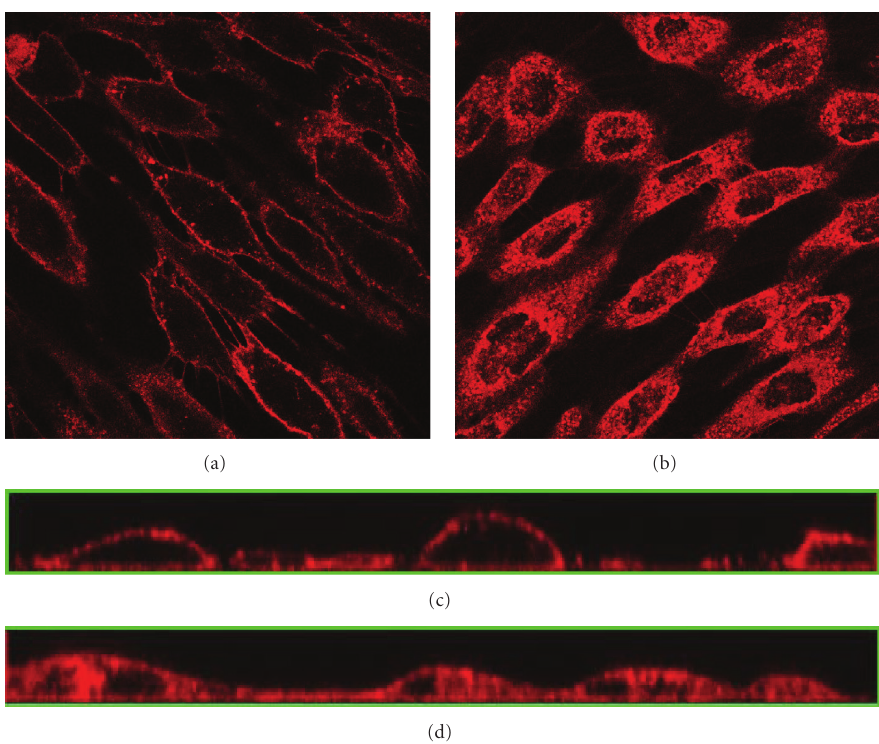
Figure 4: E ff ects of enzymatic removal of heparan sulfate before heparan sulfate staining of PAEC grown under di ff erent flow conditions for 24 hours. The glycocalyx layer is visualized under the confocal microscope through staining of heparan sulfate with Texas Red-conjugated lectin. (a) Cells grown for 24 hours exposed to laminar shear stress of 11dynes/cm 2 and then treated with HepIII for 45 minutes before staining, (b) control cells grown under static conditions for 24 hours before treatment with HepIII staining. Images are cross-sections of the cell monolayer z = 0.5–2 µ m with z = 0 at the glass surface, (c) cross-sections from the side of the stack of images of (a) created with confocal microscopy, and (d) cross-sections from the side of the stack of images of (b) created with confocal